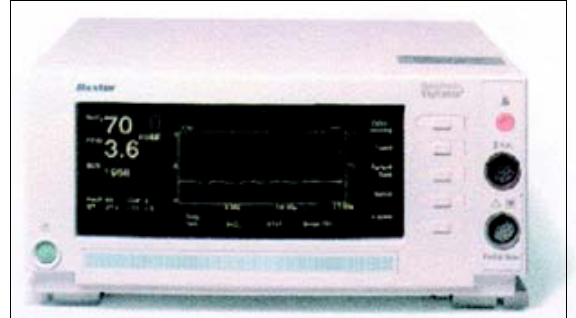
Fig. 4 (cid:150) Debimetro BAXTER** VIGILANCE para monitoriza(cid:231)ªo conti- nua do dØbito